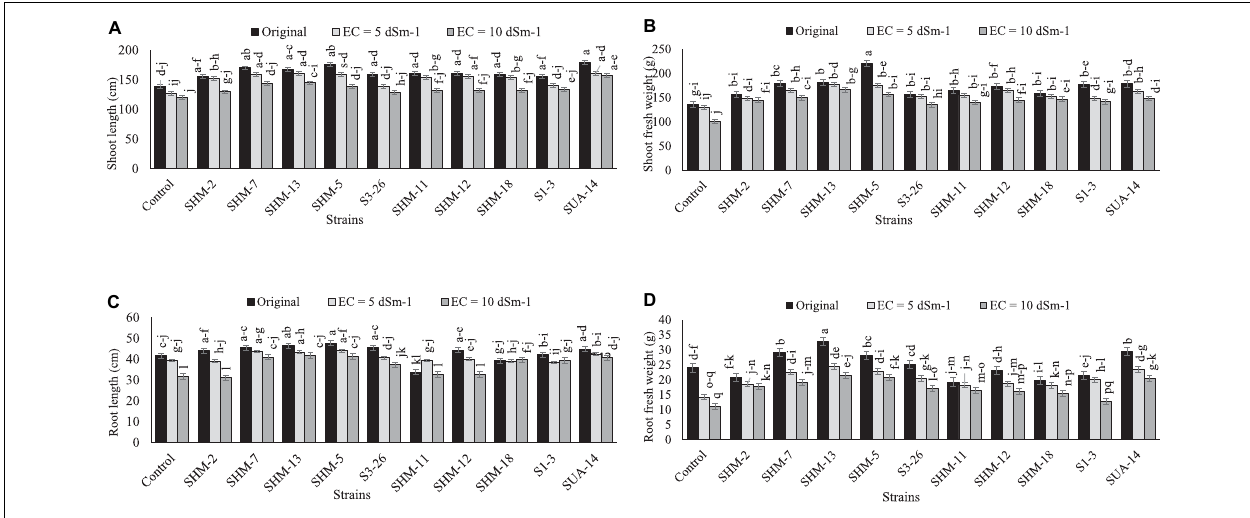
FIGURE 1 | Effect of rhizobacterial inoculation on growth parameters, i.e., (A) shoot length (cm), (B) shoot fresh weight (g), (C) root length (cm), and (D) root fresh weight (g) of maize under salt-stressed pot conditions. Bars sharing similar letters are statistically non-significant at p ≤ 0.05.